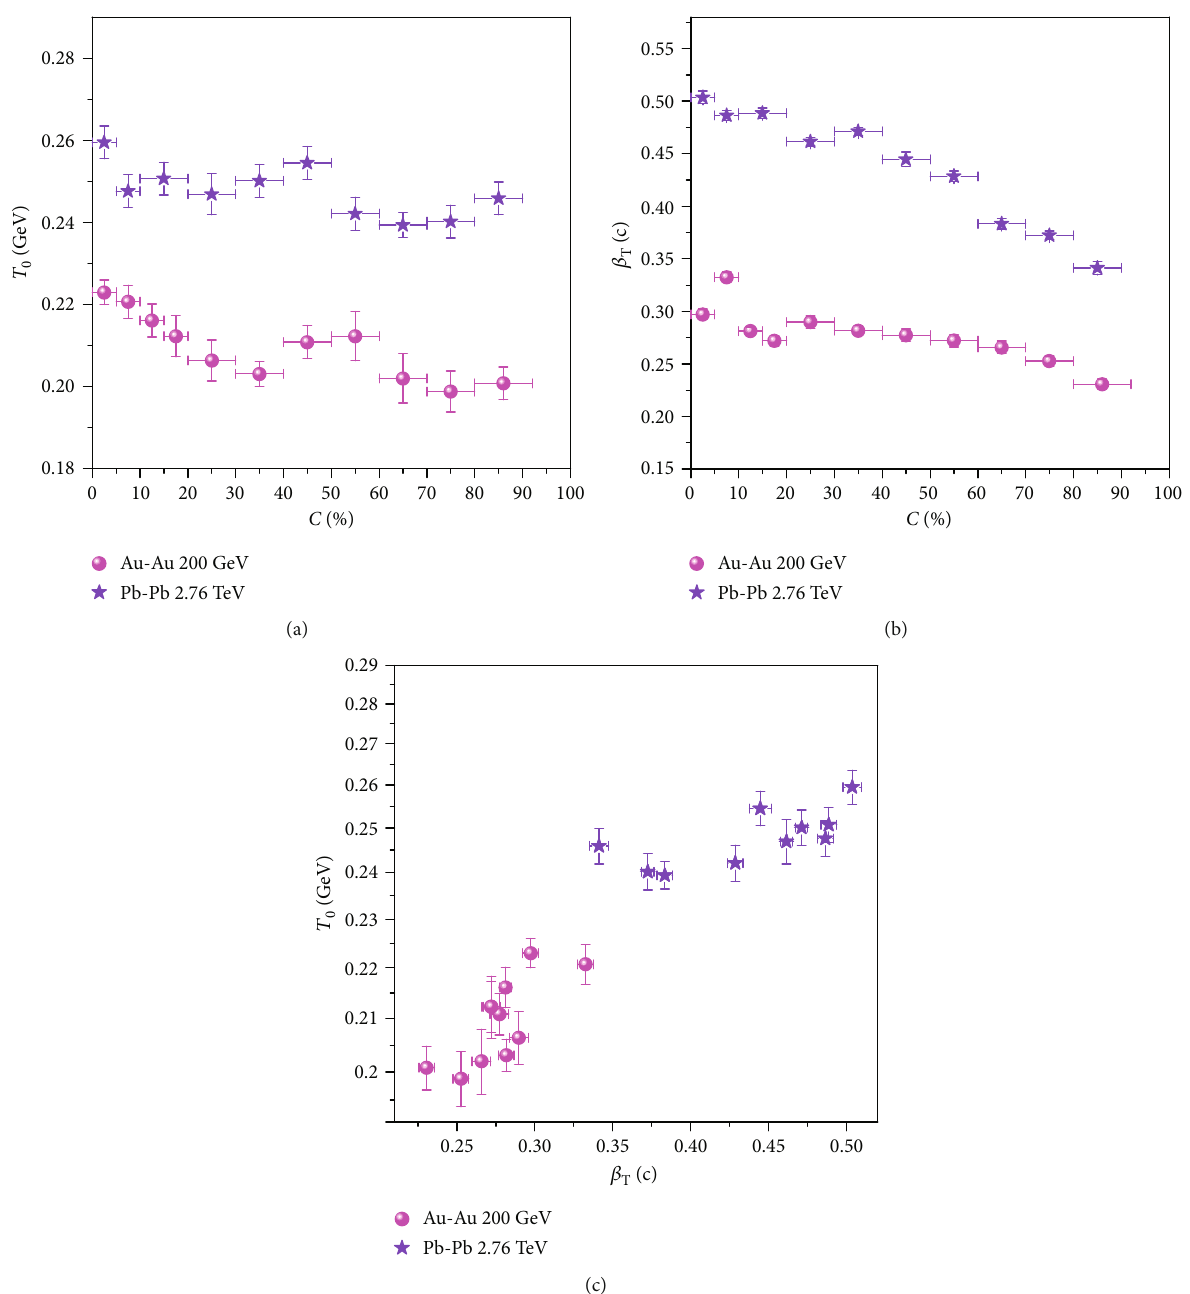
fl ow velocity β T on centrality C